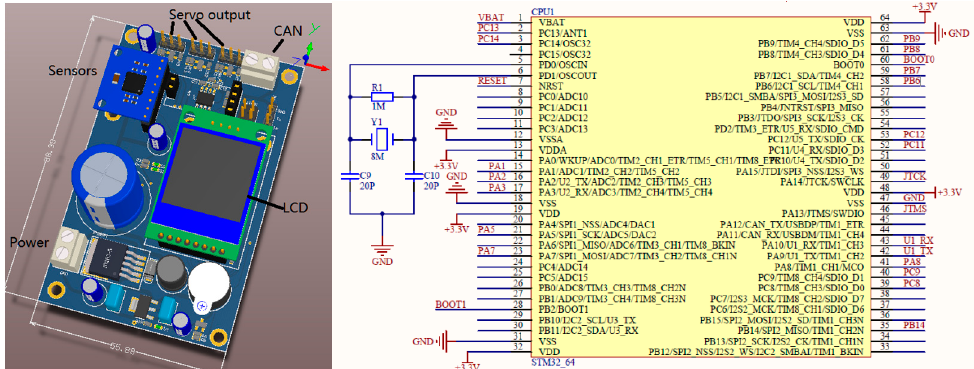
Figure 4. Far-end gimbal controller sketch and wiring diagram.